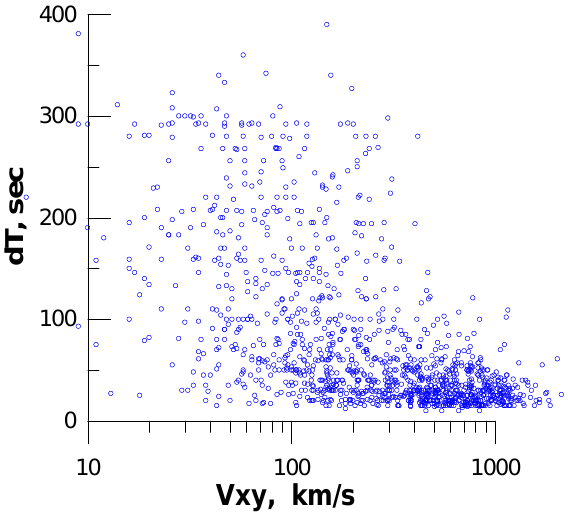
Fig. 6. Relationship between the neutral sheet flow amplitude V xy = ((V x 2 + Vy 2 ) 1 / 2 ) and duration of the CS crossings. Short crossings (12 to 30s) were also included in this